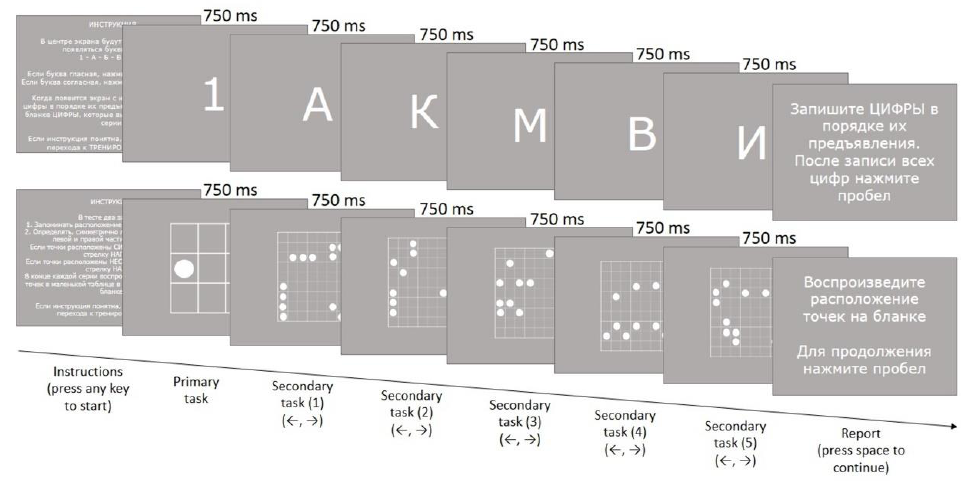
Figure 1. Experimental sequence of stimuli presentation during the letter reading span and symmetry span tasks.